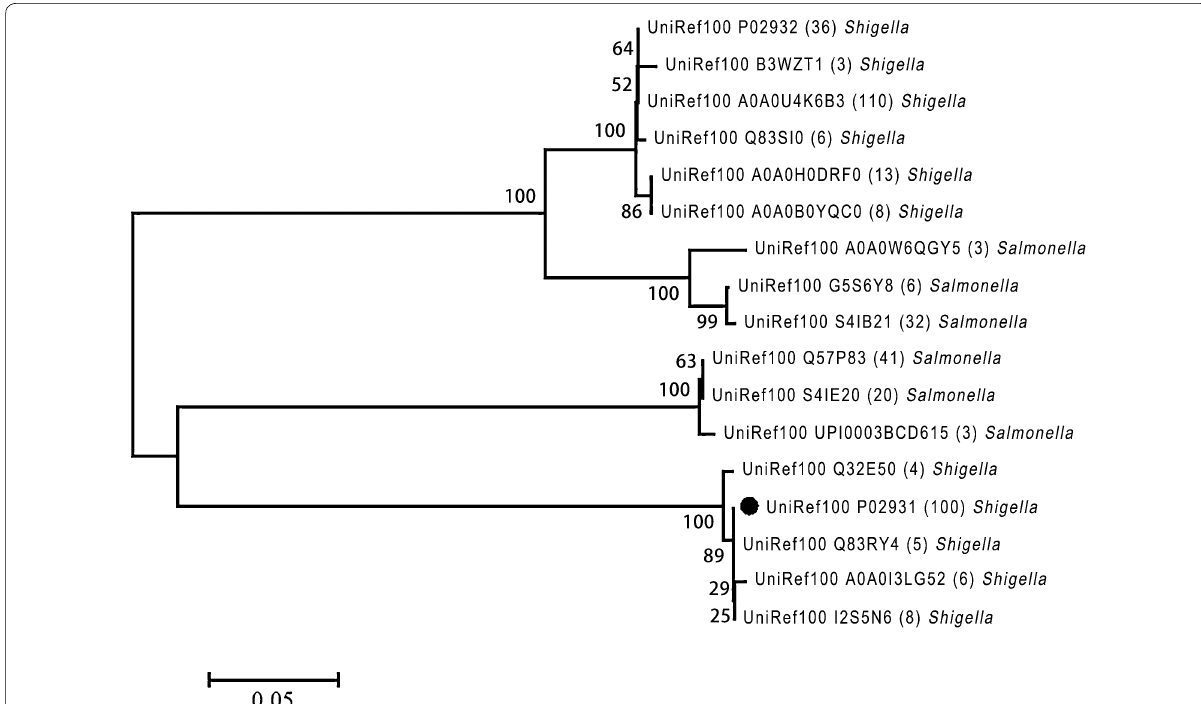
Fig. 2 Homology and phylogenetic analysis of the OmpF protein. Phylogenetic analysis of the OmpF protein in Shigella and Salmonella (omit the clusters less than 3 in size). Black symbol indicates the protein clusters which were identical to that of E. coli CVCC 1515